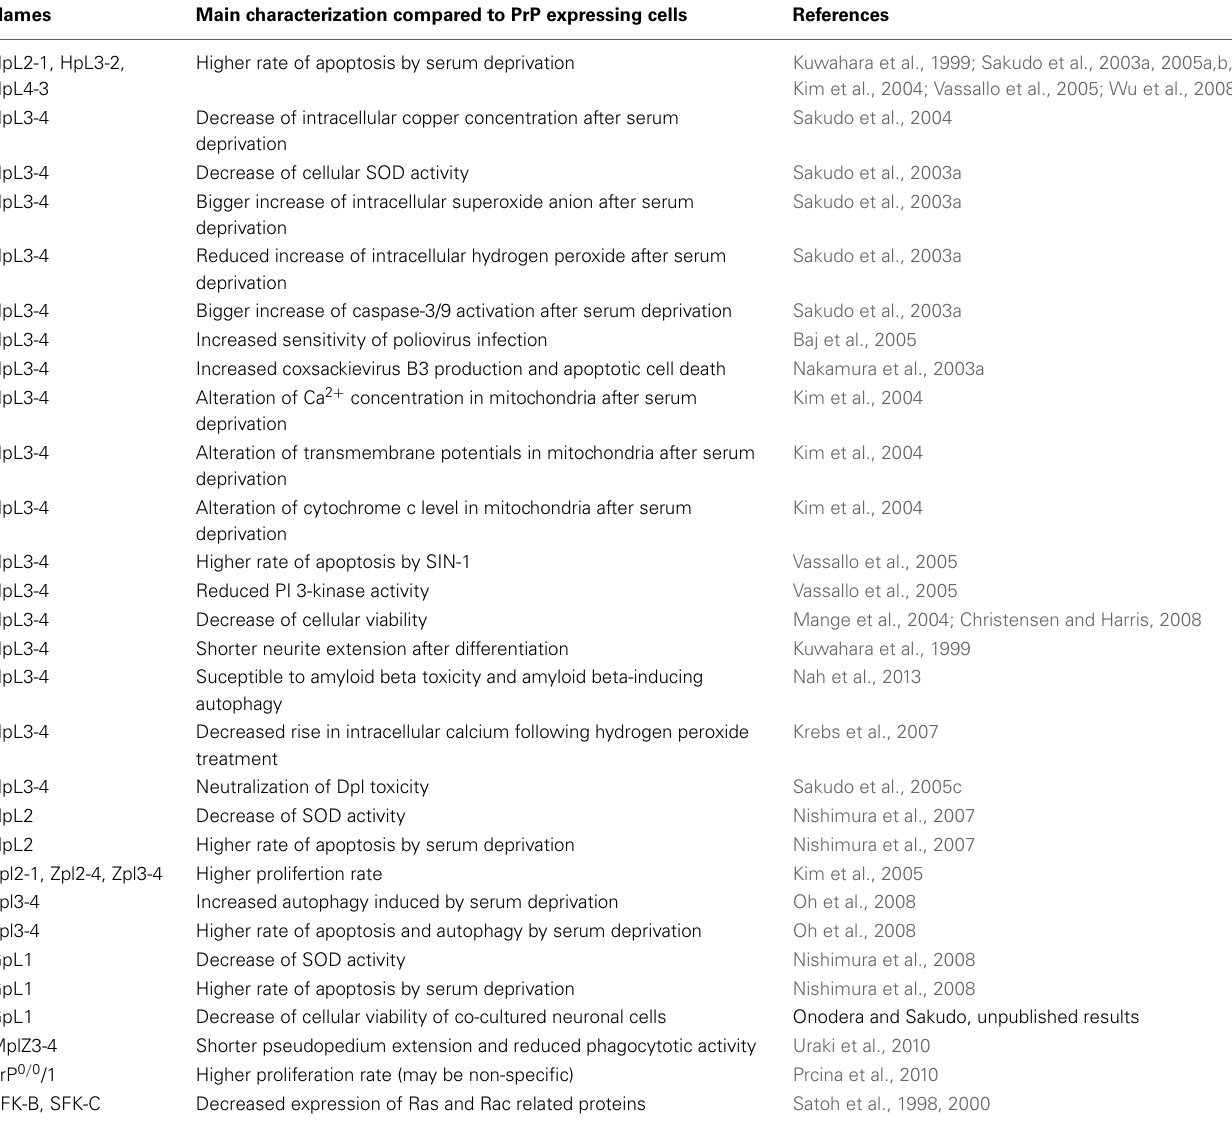
Table 2 | Abnormality of PrP gene-deficient cell